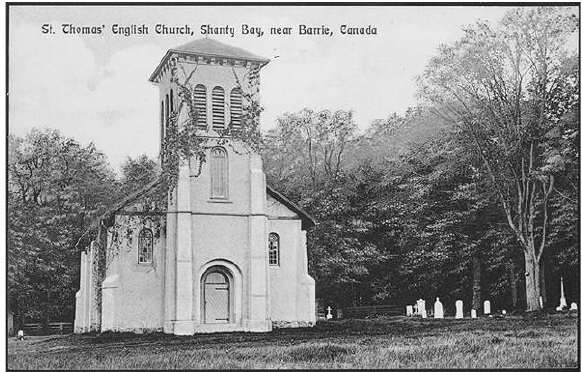
Figure 11. St. Thomas' English Church, Shanty Bay, near Barrie, Canada, N.W.E. King, Picture, 1910 (Source: Courtesy of Toronto Public Library).